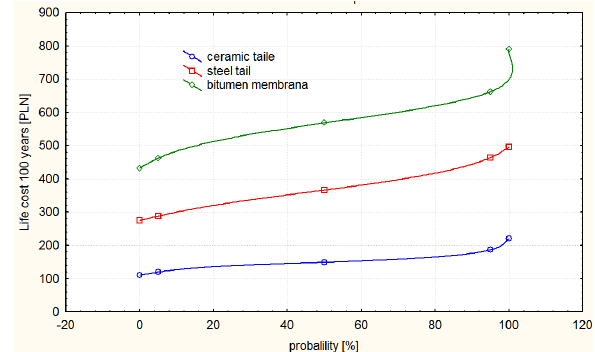
Figure 2: The cost of installing and using roof coverings over a 100- year period as a probability function from 0% to